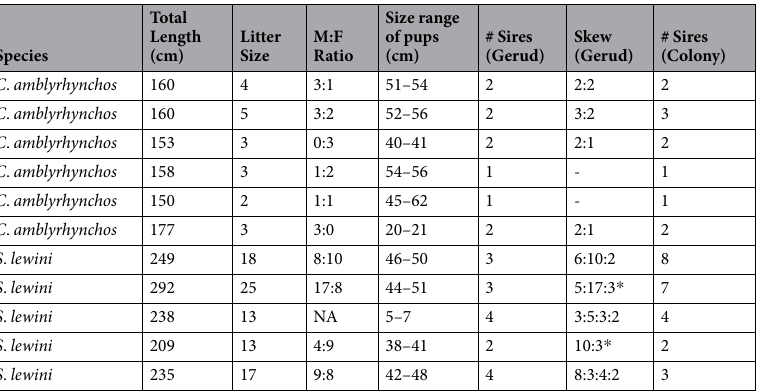
Table 2. Summary of analysed litters, including female total length, litter size, sex ratio of pups (M:F Ratio), size range of pups, number of sires as estimated by Gerud and Colony, skew (paternal) for grey reef sharks ( C. amblyrhynchos ) and scalloped hammerhead ( S. lewini ). NA Indicates pups were too young to identify sex, * P < 0.05 chi-square test.